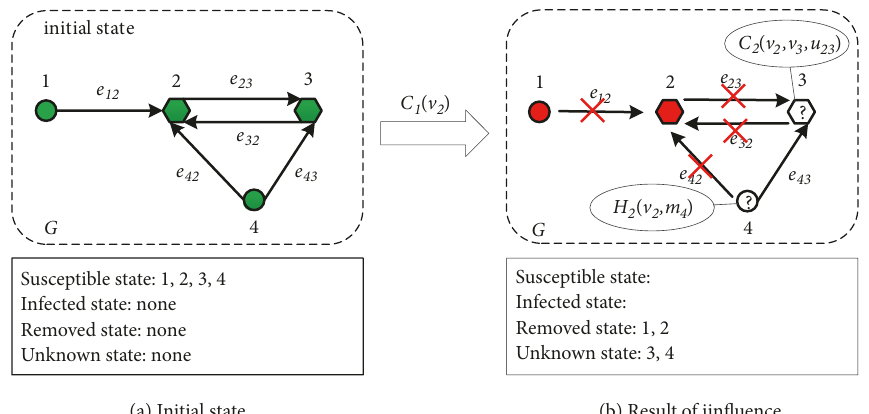
Figure 3: Influence of bankruptcy of listed company 2 on the network.